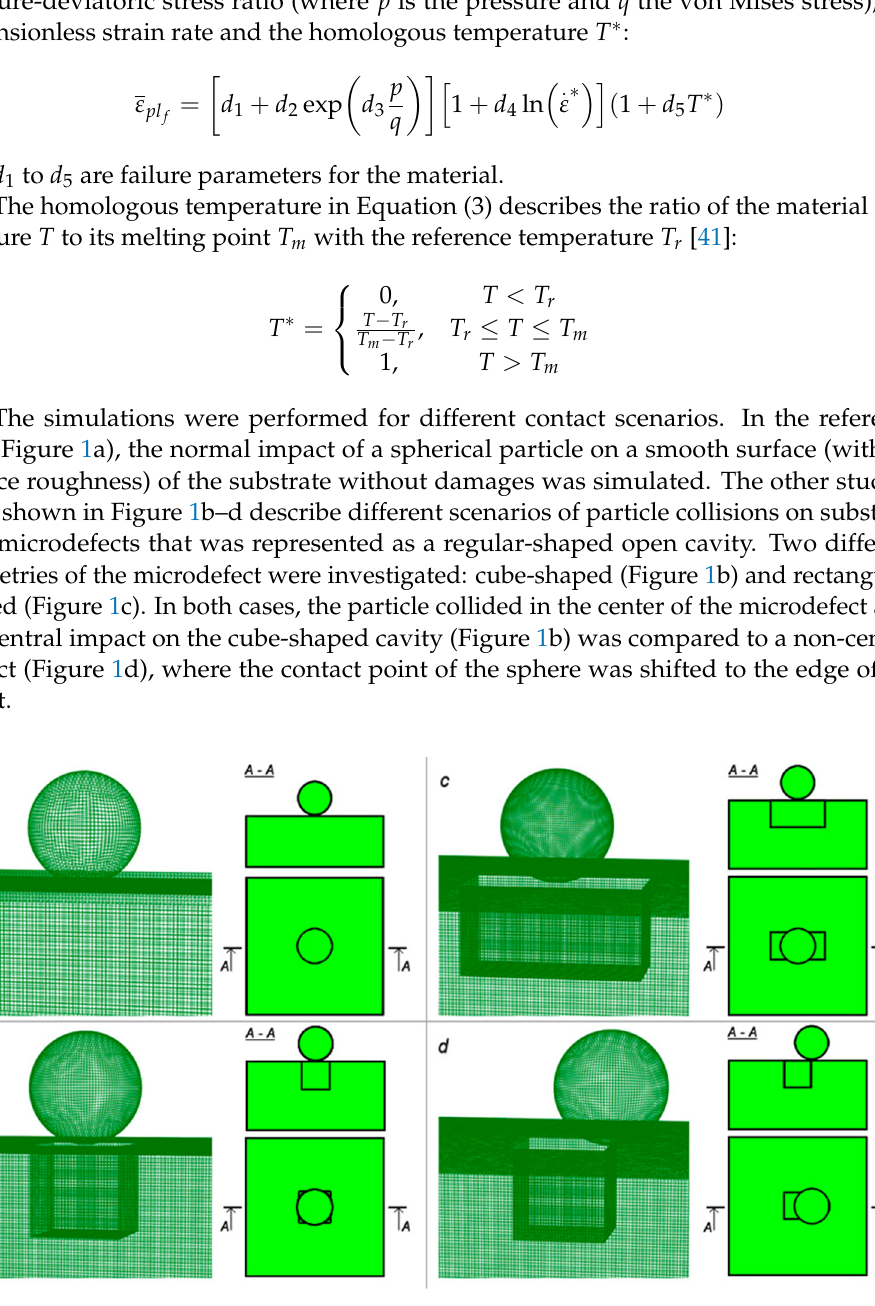
Figure 1. Showing 3D FEM models of simulated collision cases and corresponding initial orientation of the particle relative to substrate domain: ( a ) without microdefect (smooth surface); ( b ) with cube- shaped microdefect; ( c ) with rectangular-shaped microdefect; ( d ) with the particle collision on the edge of cube-shaped microdefect.